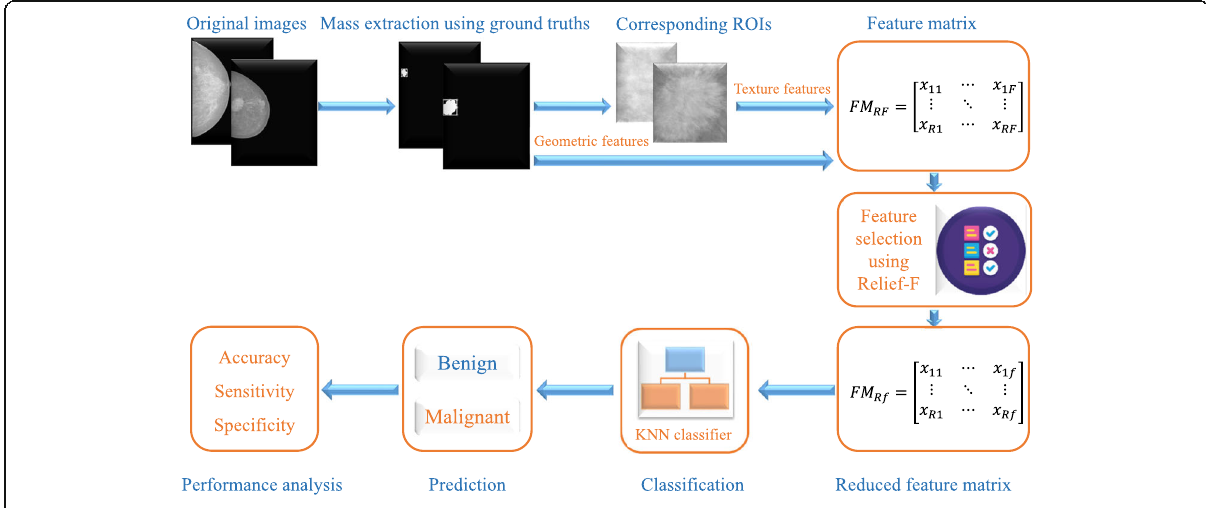
Fig. 1 The schematic diagram of the proposed CAD system